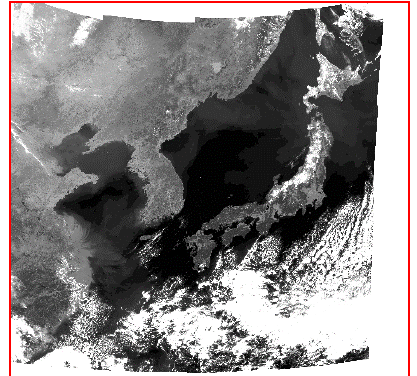
Figure 8. Mosaicking result by using proposed method